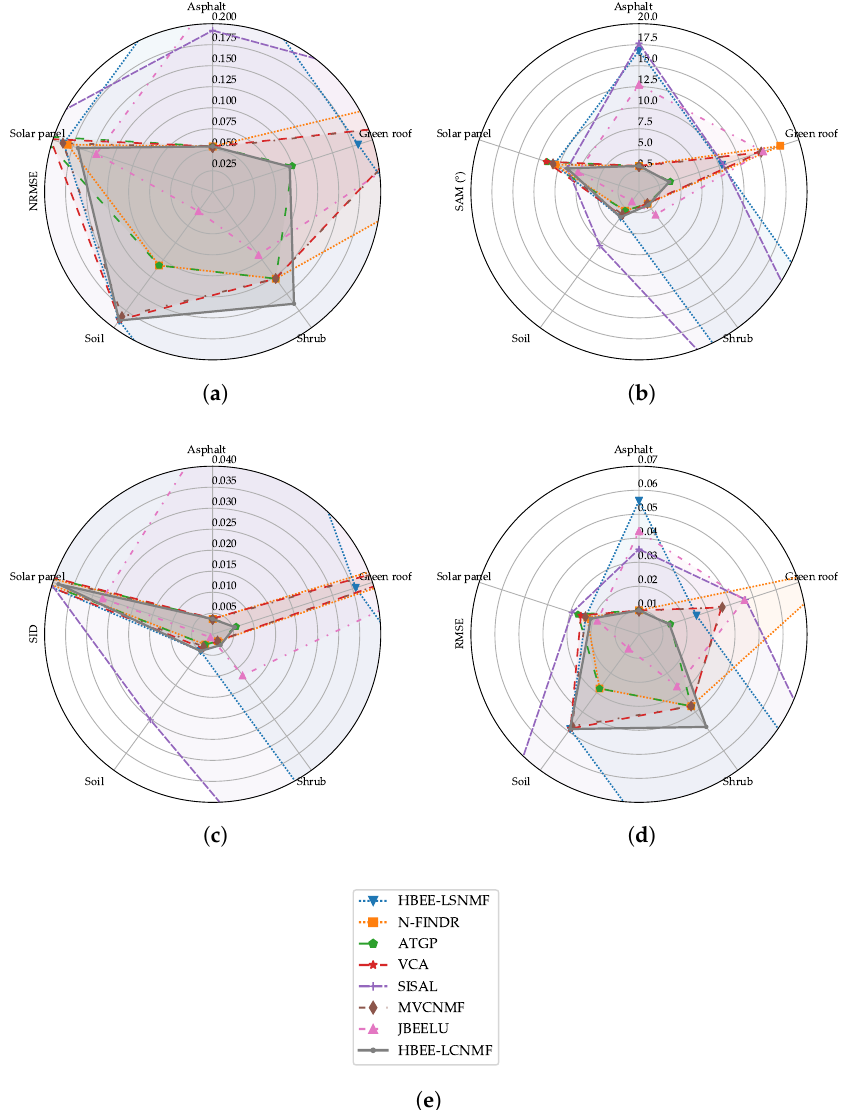
Figure 17. NRMSE ( a ) , SAM ( b ), SID ( c ), and RMSE ( d ) performances for each estimated endmember for the Mauzac data set. Legend is given in ( e